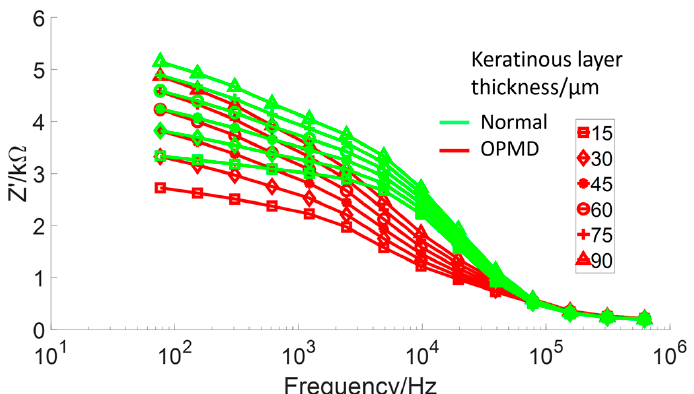
Figure 10. Comparison of healthy and severely dysplastic oral tissue impedance spectra with increasing keratinised thickness.